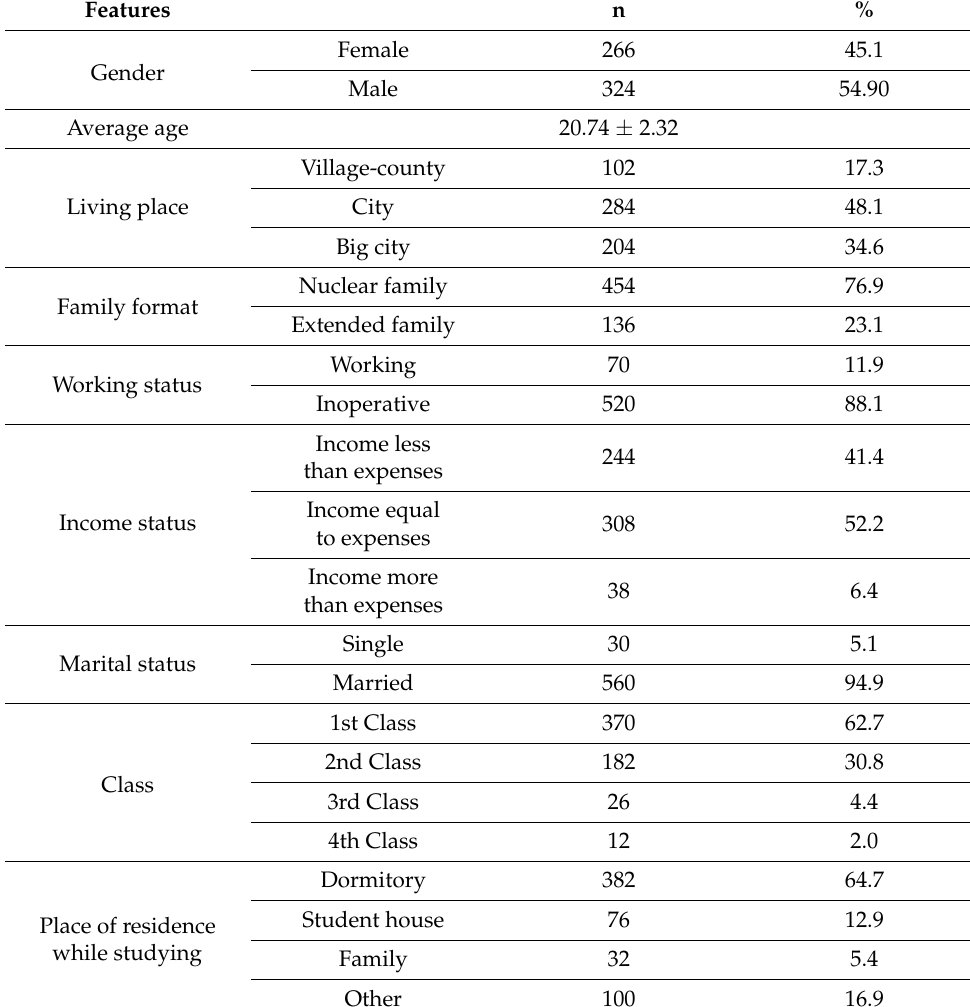
Table 1. Distribution of students according to their sociodemographic